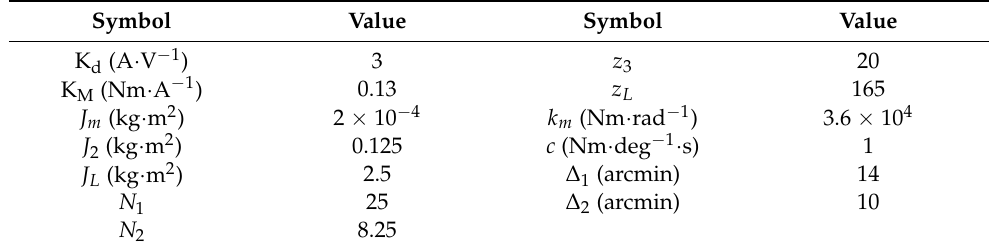
Table 1. System parameter values.